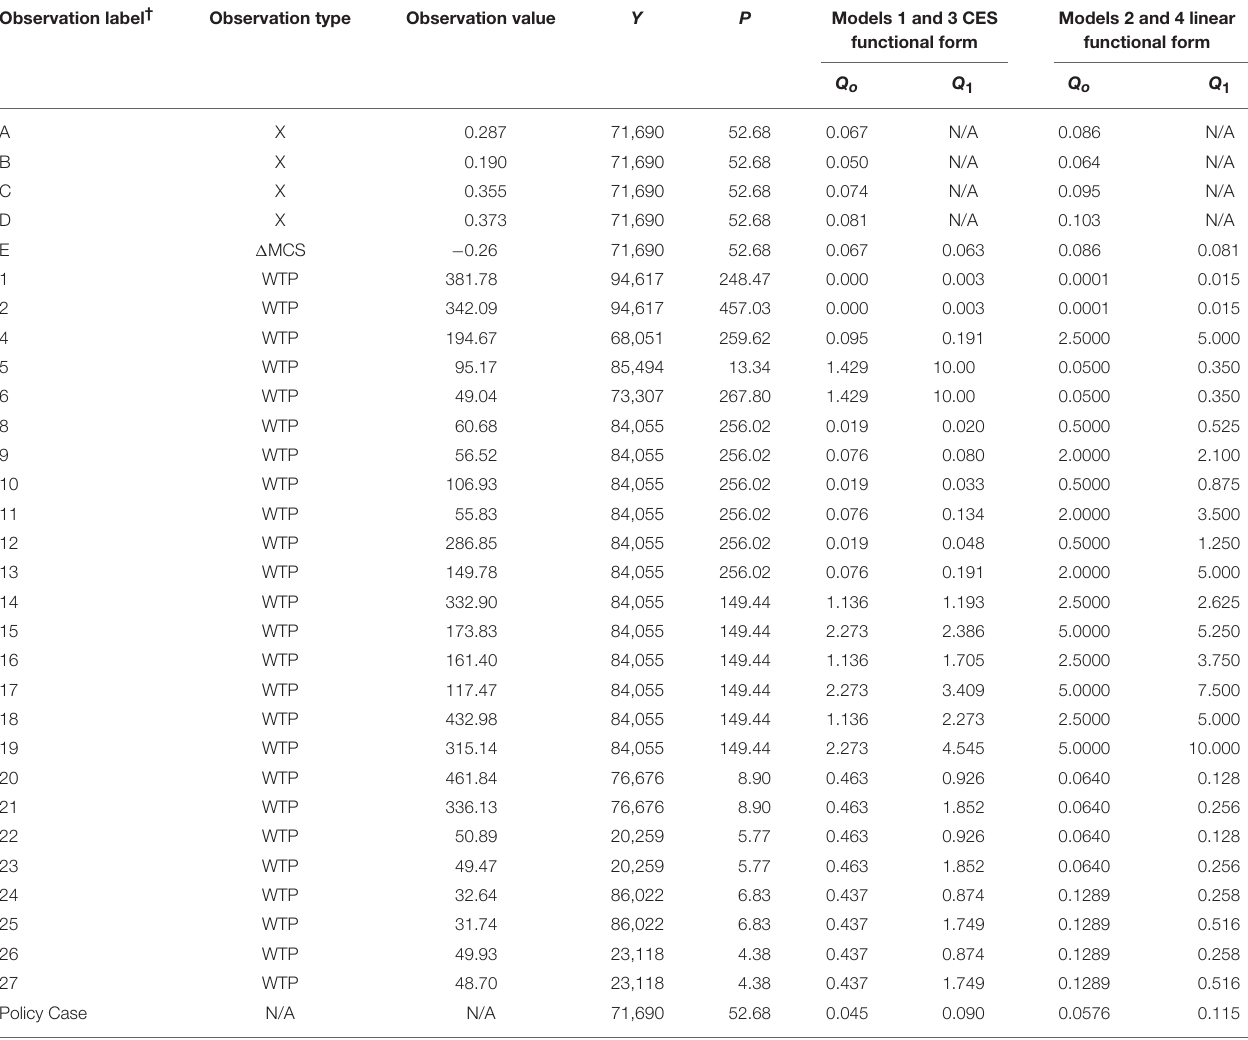
TABLE 5 | Structural benefit transfer of the total economic value of migratory pacific salmon abundance changes in the US. Observation label